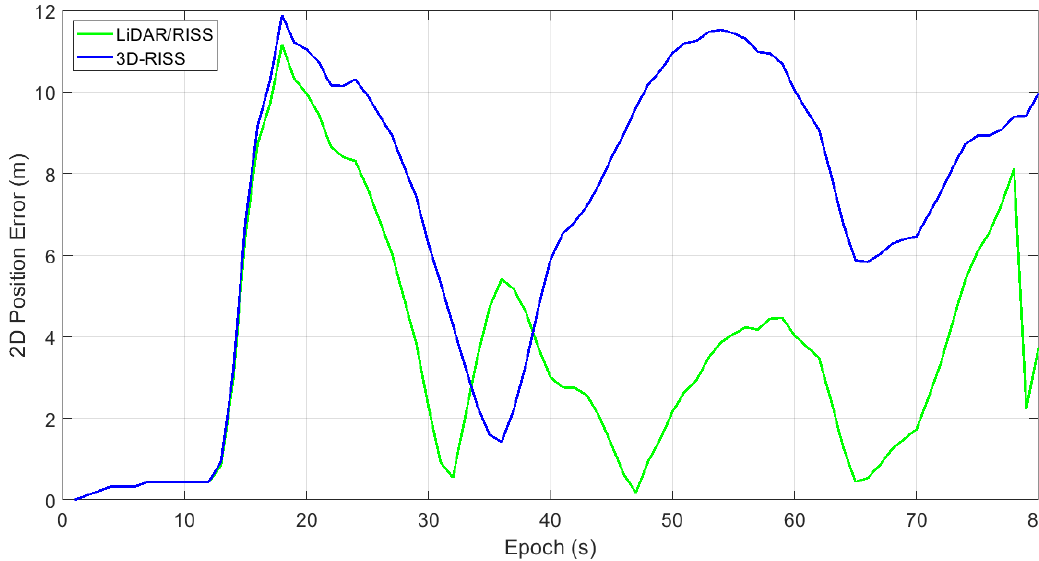
Figure 16. 2D Position Error for Simulated Outage 1, First Trajectory.